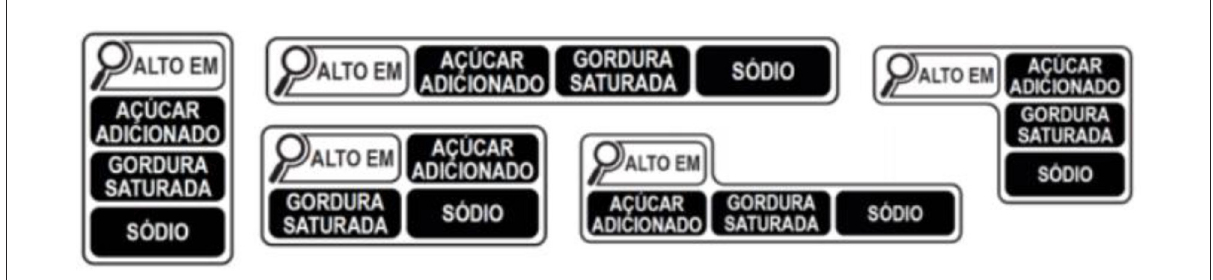
FIGURE1 The FoPNL design model approved by Anvisa. Brazil, 2020. Source: